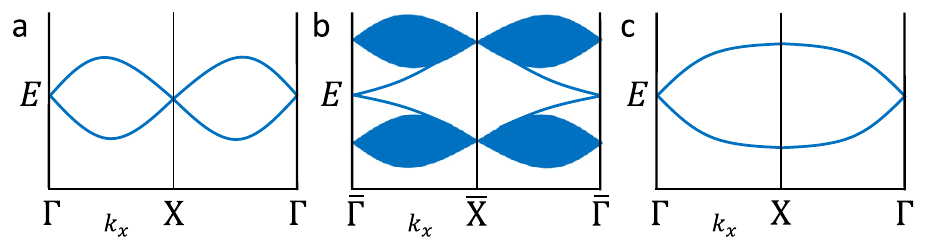
Fig. 4 Dirac fermion doubling from elementary band (co)representations. a A pair of spinful bands that transform in the double-valued EBR of a Type-II line group generated by f T j 0 g and lattice translation [isomorphic to Type-II double SG 1.2 P 11 0 modulo lattice translations]. At half- fi lling, there are two, twofold Dirac fermions in ( a ), representing an example of twofold Dirac fermion doubling in 1D. b The edge spectrum of a 2D TI features an unpaired twofold Dirac fermion that circumvents the doubling theorem in (a) 17,18,21 . (c) A pair of spinful bands that transform in the double-valued MEBR of a Type- IV magnetic line group generated by f T j 1 = 2 g [isomorphic to Type-IV double MSG 1.3 P S 1 modulo lattice translations]. At half- fi lling, the spectrum in ( c ) consists of an unpaired twofold Dirac fermion with the same k ⋅ p Hamiltonian as the Dirac points at Γ and X in ( a ) and the 2D TI edge in ( b ), representing a magnetic exception to twofold Dirac fermion doubling in